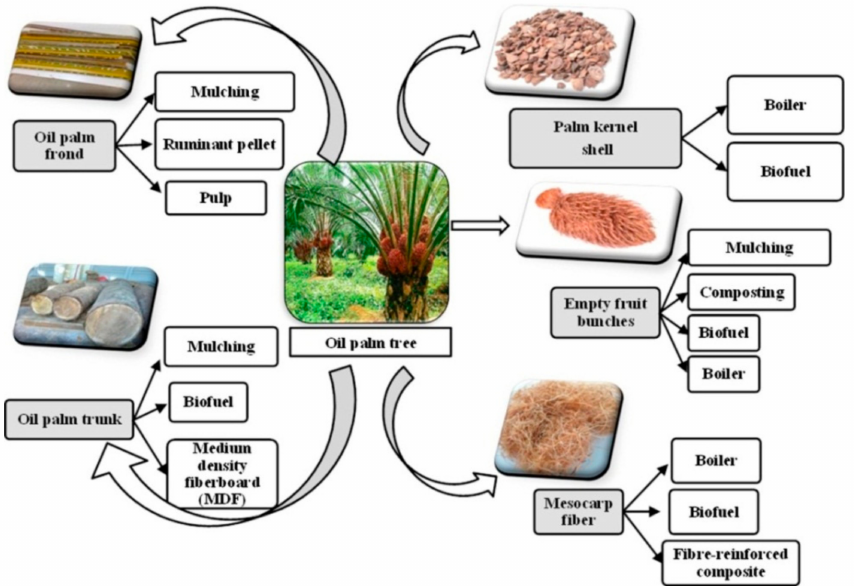
Figure 1. The present use of oil palm solid wastes [22]. Reprinted with permission from Elsevier